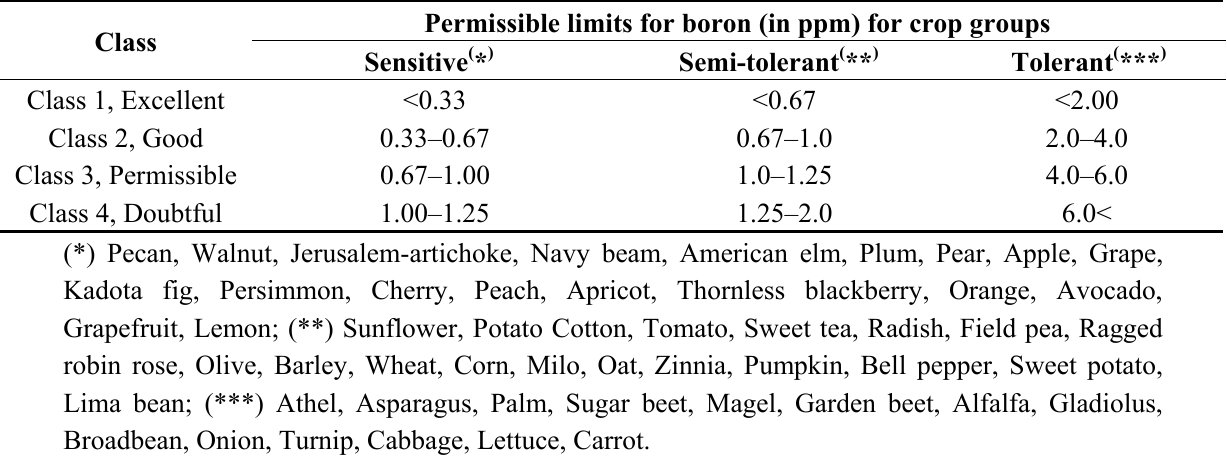
Table 3. Approximate limits of boron in irrigation water/effluent